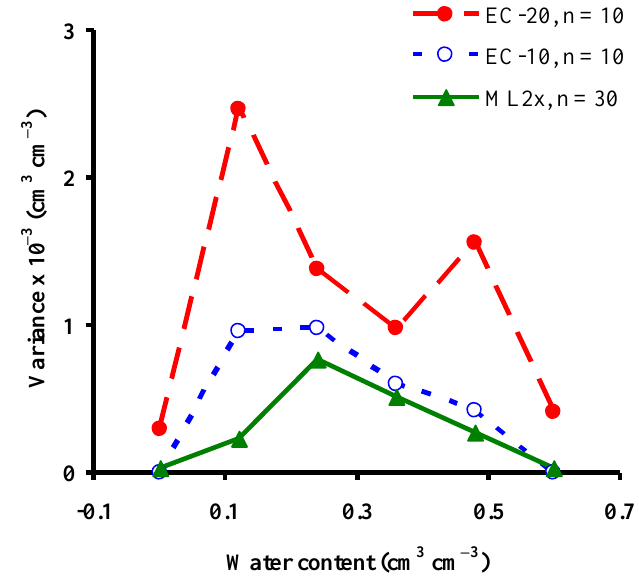
Figure 5. Precision of the EC-10, EC-20, and ML2x sensors judged from the variance of sensor’s readings repeatedly (n = 10 for the ECH O sensors; and n = 30 for the ML2x, 2 where n is number of repeated measurements) taken at the same water content